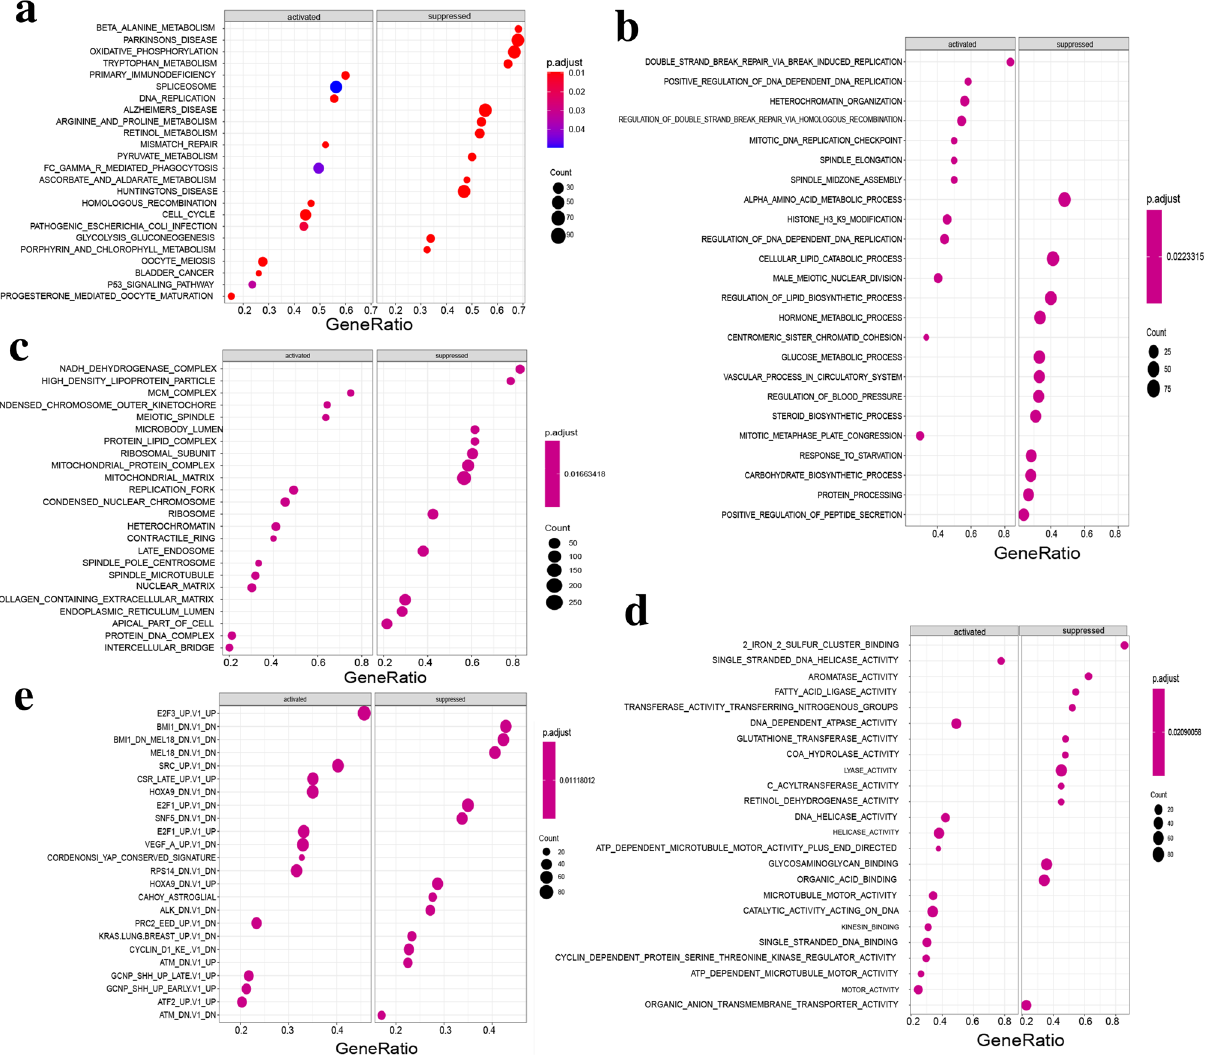
Figure 5. GSEA results between low-risk and high-risk group of HCC patients of the prognostic model. ( a ) Top 12 KEGG pathways activated (left) and suppressed (right) by high-risk group. ( b–d ) Top 12 gene sets of GO term activated (left) and suppressed (right) by high-risk group. Among them, results of biological process (BP) were presented in ( b ); results of cellular compartment (CC) were presented in ( c ); results of molecular function (MF) were presented in ( d ). ( e ) Top 12 gene sets of oncogenic signatures activated (left) and suppressed (right) by high-risk group. For ( a–e ), the size and color of nodes represent the number of enriched genes and adjusted P